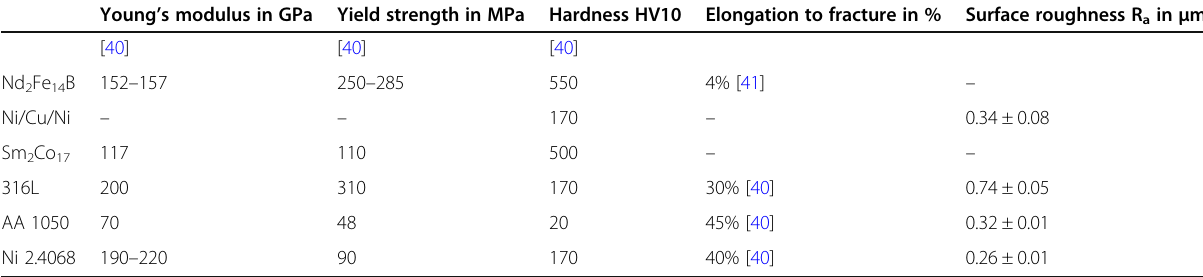
Table 1 Mechanical properties and surface roughness of the materials used in the welding